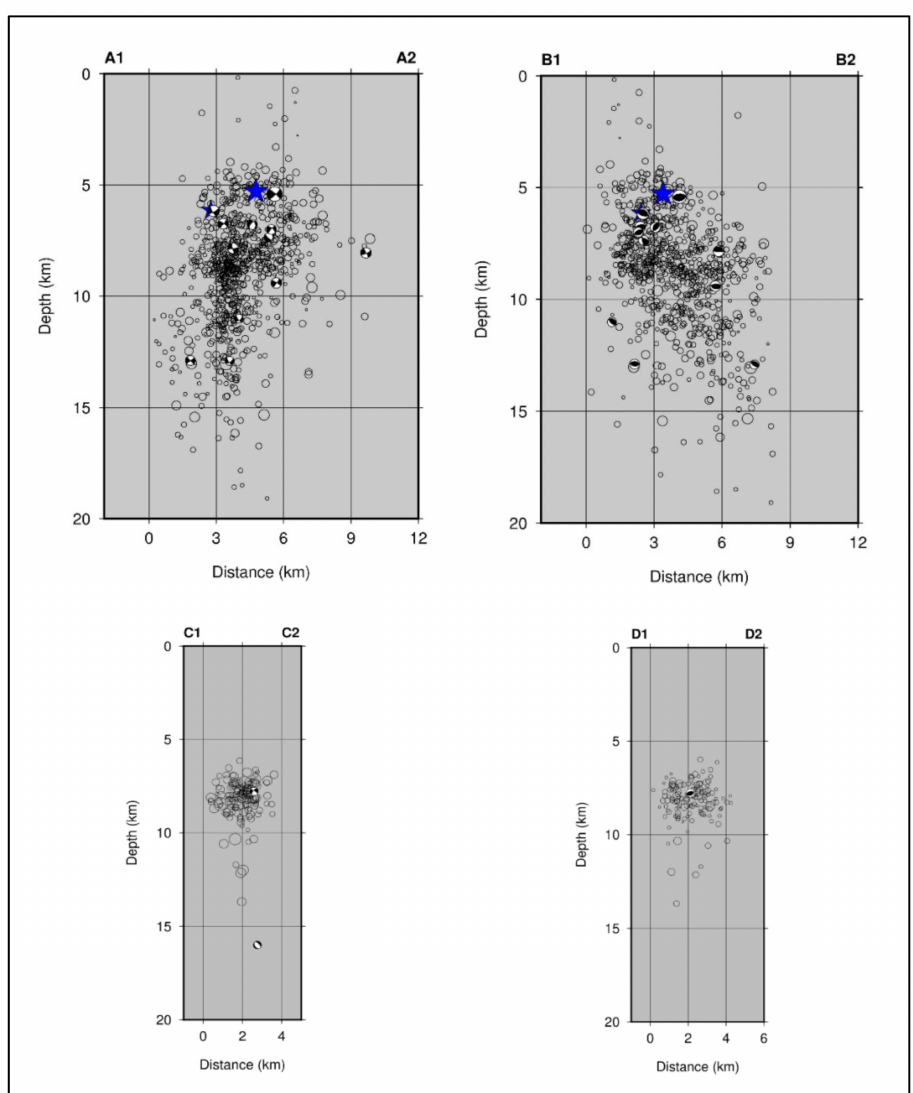
Figure 4. Relocated seismicity cross-sections. Beachballs show focal mechanisms (projected to the plane of the cross-sections). See map in Figure 3 for